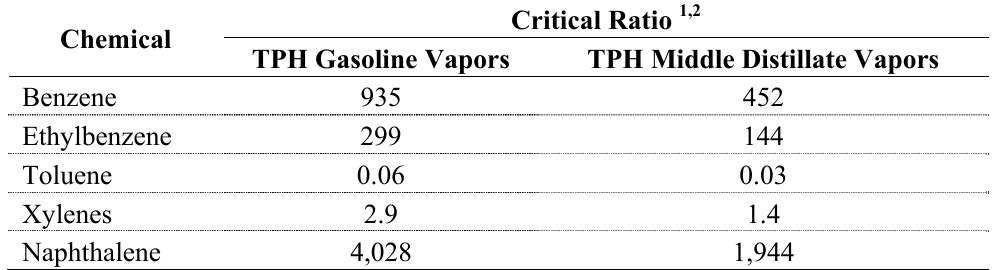
Table 8. Example critical ratios over which TPH in soil vapor will drive vapor intrusion risk over individual